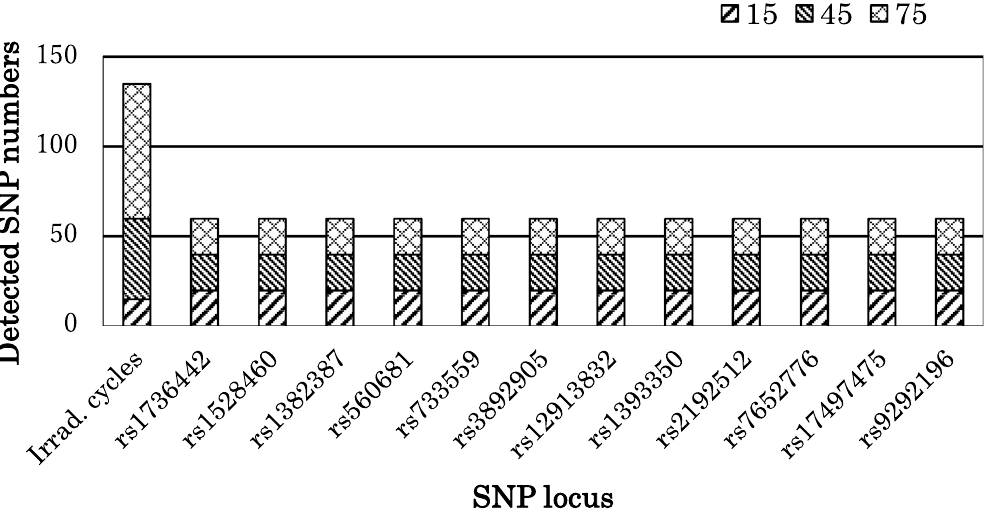
Figure 3. Genotyping of SNPs amplified from UV irradiated bloodstains from 20 bloodstain